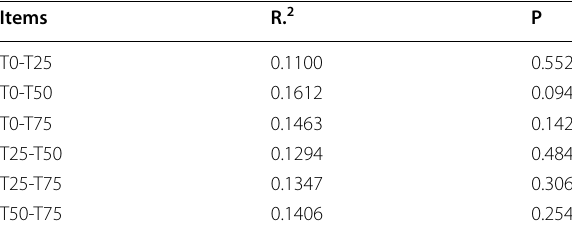
Table 4 Adonis multivariate analysis of variance